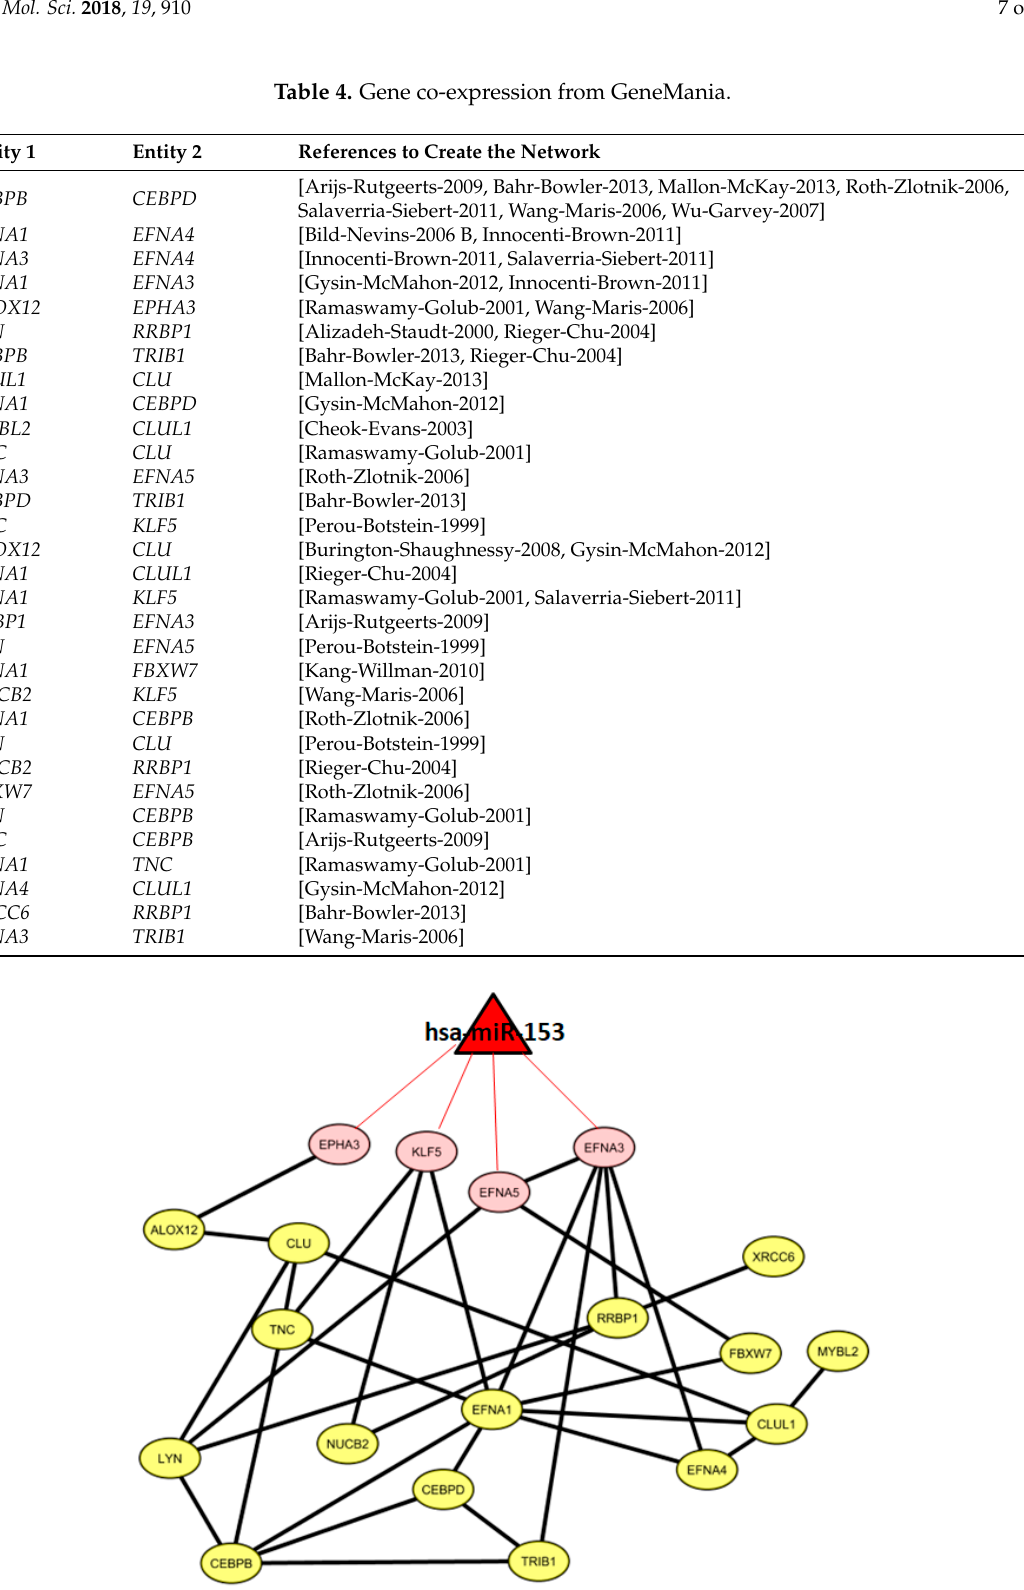
Table 4. Gene co-expression from GeneMania.